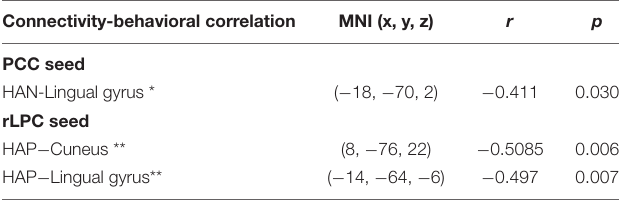
TABLE 5 | Statistical results of correlation coefficients between each of the four affective states and ASMR condition-specific connectivity changes. Connectivity-behavioral